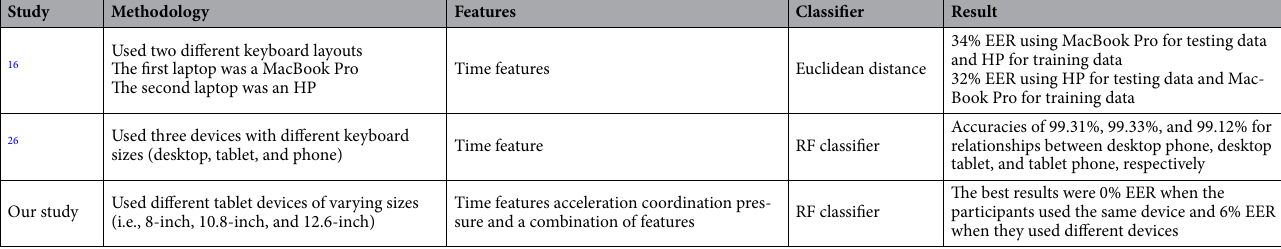
Table 5. A comparison of our system results and the results from 16 and 26